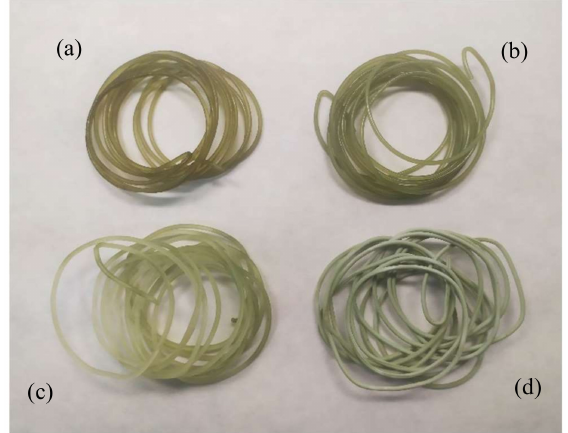
Figure 4. PLA filaments impregnated with MLE: ( a ) 35 ◦ C, 100 bar; ( b ) 35 ◦ C, 400 bar; ( c ) 55 ◦ C, 400 bar; and ( d ) 55 ◦ C, 100